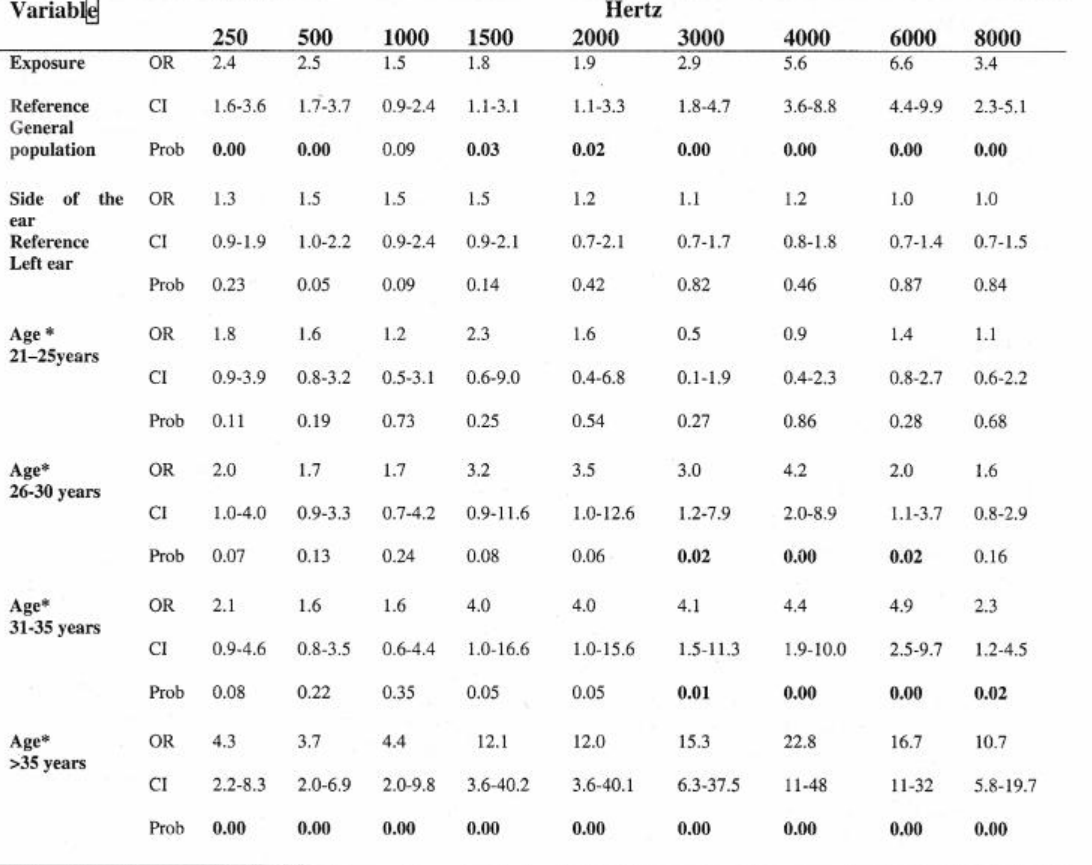
Table 6 : Audiometry by exposure,side of ear and agecategories ~ study and control groups